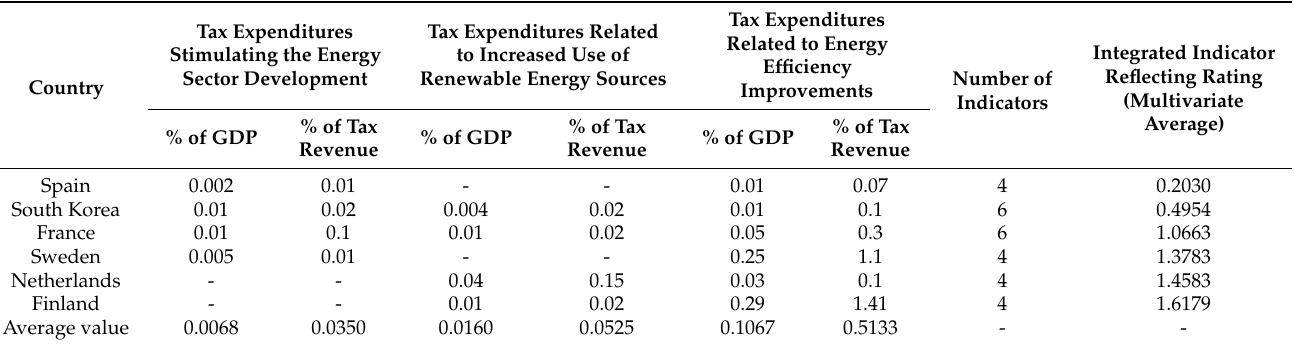
Table 5. Multivariate average indicator, reflecting the rating of each country in estimating the scale of tax